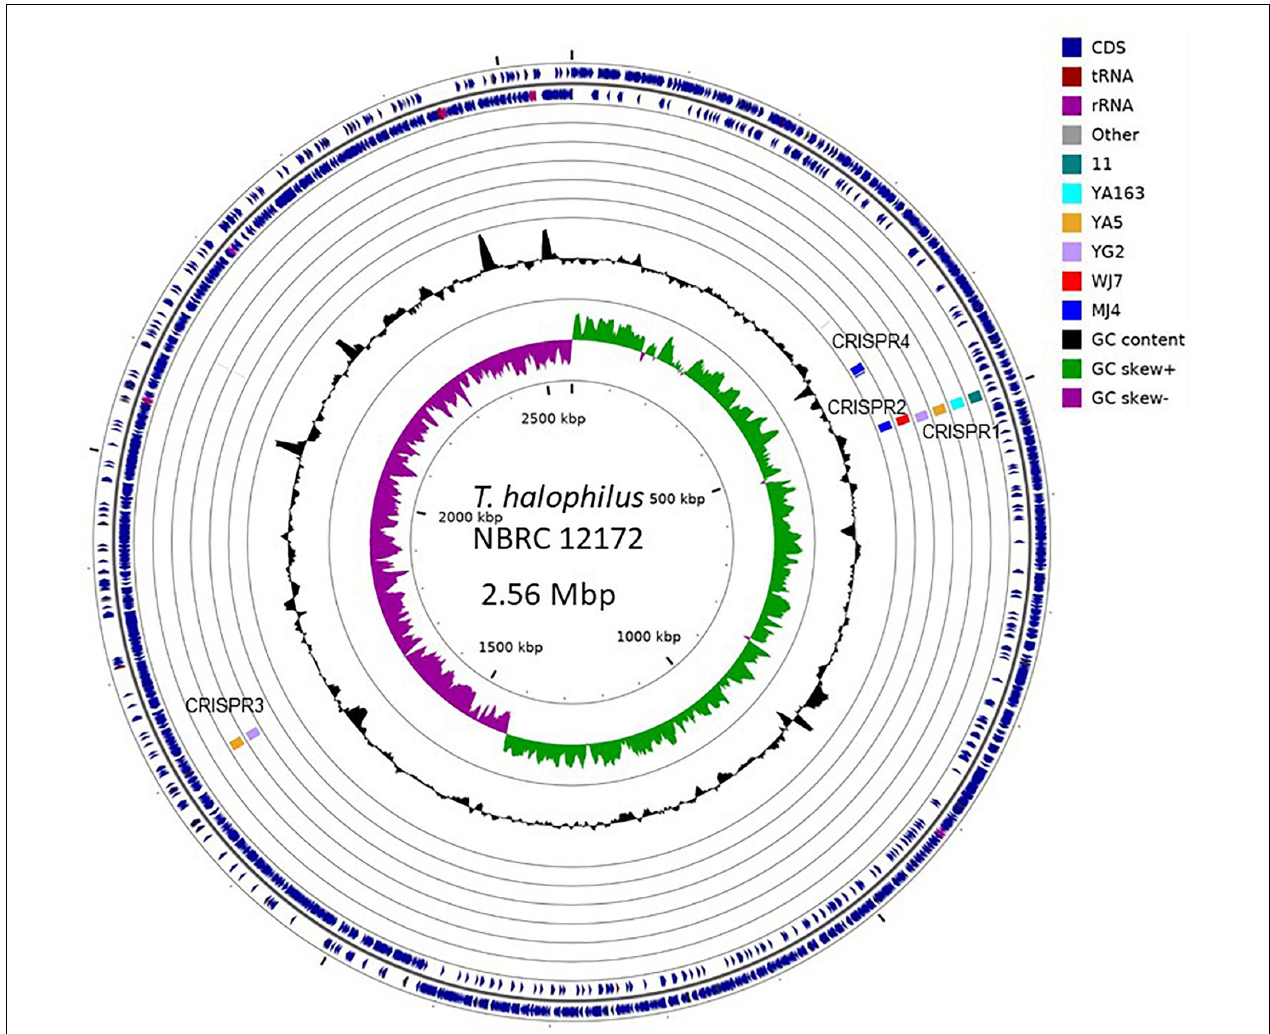
FIGURE 3 | Graphical representation of CRISPR inserted regions. Insertion points were identified with NUCmer alignment (Marçais et al., 2018). Each query genome was independently aligned against the complete genome sequence (GenBank acc. No.: AP012046.1) of the Tetragenococcus halophilus NBRC 12172 strain. The illustration was produced using CG-view (Stothard and Wishart,